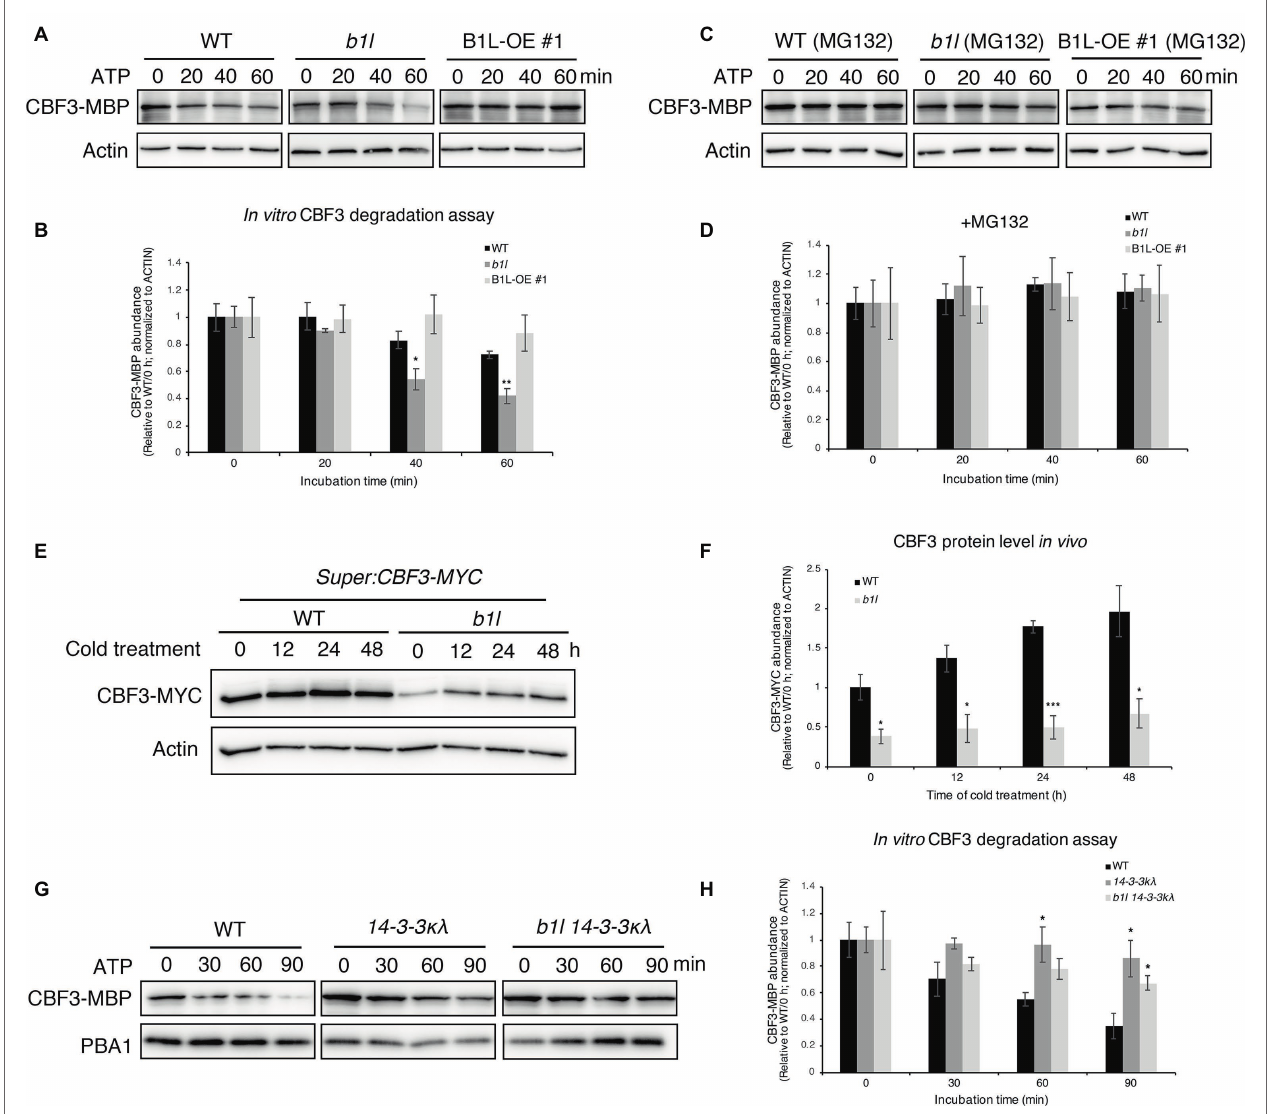
FIGURE 7 | B1L inhibits the ubiquitin-mediated degradation of CBF3 via a 14-3-3 λ -dependent way. (A–D) In vitro cell-free degradation assay showing that B1L inhibits the degradation of CBF3. The recombinant purified CBF3-MBP proteins were incubated with the total proteins extracted from wild type, b1l or B1L-OE #1 seedlings in the presence of ATP. These total proteins were pretreated with or without 50 μM MG132 (an inhibitor of 26S proteasome degradation) for 3 h. Typical immunoblotting results were shown (A,C) , along with quantification (B,D) . Actin was used as a control. The ratio of the band intensity of CBF3-MBP to actin without the ATP treatment was set to 1. The data are shown as means of three independent biological replicates ± SE. Asterisks indicate significant differences (* p < 0.05, and ** p < 0.01) from wild type. (E,F) In vivo degradation assay showing that the CBF3 is stabilized by B1L under cold stress. Super:CBF3-MYC transgenic plants were crossed with b1l to generate Super:CBF3-MYC / b1l transgenic plants, and then the protein level of CBF3-MYC in both wild type background and b1l background was tested after different times of cold treatment. Actin served as a control. The ratio of the band intensity of CBF3 to actin without the cold treatment in Super : CBF3-MYC plants was set to 1. The data are shown as means of four independent biological replicates ± SE. Asterisks indicate significant differences (* p < 0.05, and *** p < 0.001) from Super : CBF3-MYC plants. (G,H) In vitro cell-free degradation assays showing that B1L inhibits the degradation of CBF3 via 14-3-3 λ . The recombinant purified CBF3-MBP proteins were incubated with the total proteins extracted from wild type, 14-3-3 λ or b1l 14-3-3 λ seedlings in the presence of ATP. PBA1 was used as a control. The ratio of the band intensity of CBF3-MBP to actin without the ATP treatment was set to 1. The data are shown as means of three independent biological replicates ± SE. Asterisks indicate significant differences (* p < 0.05) from wild